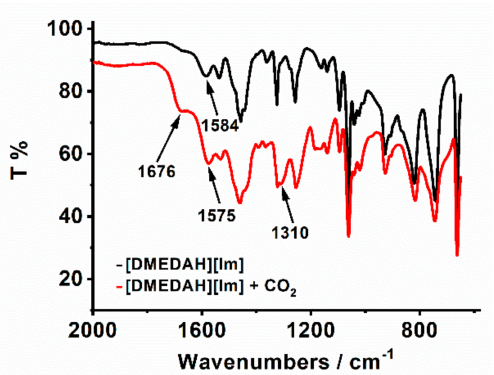
Figure 4. The FTIR spectra of [DMEDAH] [Im] before and after CO 2